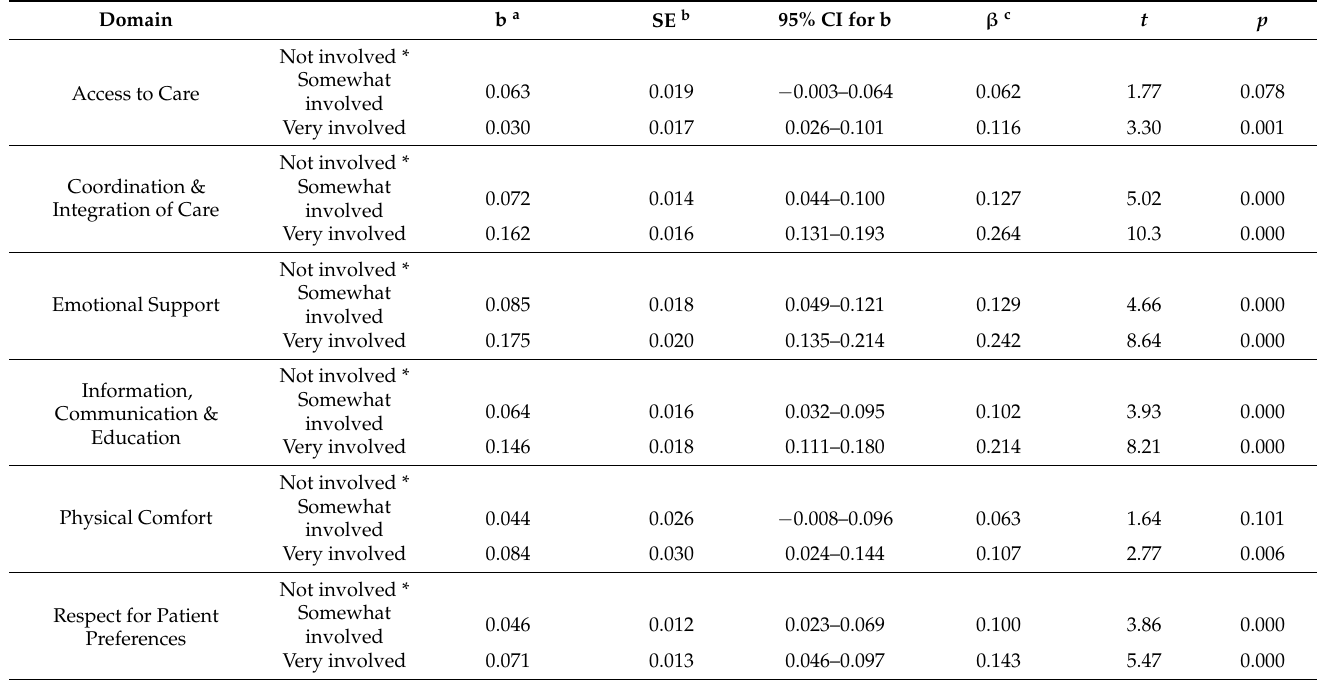
Table 2. Linear regression analysis summary for family doctor involvement on six domains of person-centred